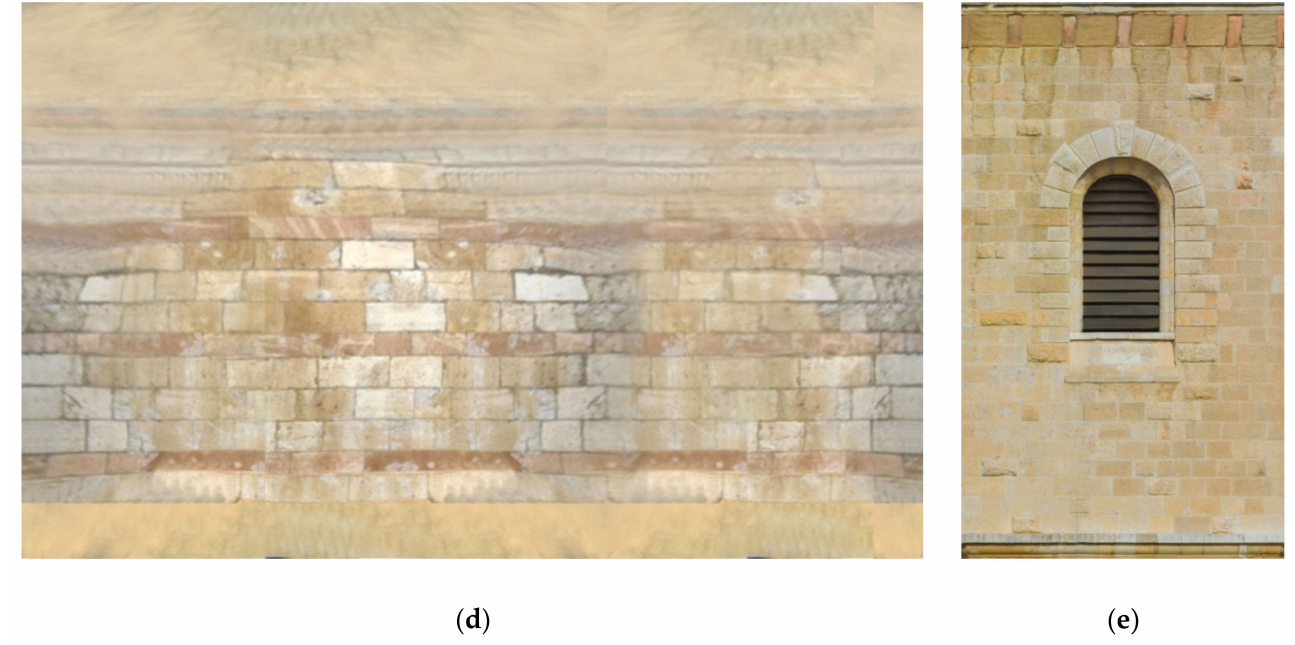
Figure 12. Exemplary material bitmaps for ( a ) the main rounded wall of the basilica rotunda, ( b ) the buttress separating the rotunda rounded walls, ( c ) the surface of the rotunda side turrets (one of six bitmaps), ( d ) the tower dome, and ( e ) the tower in the part under the